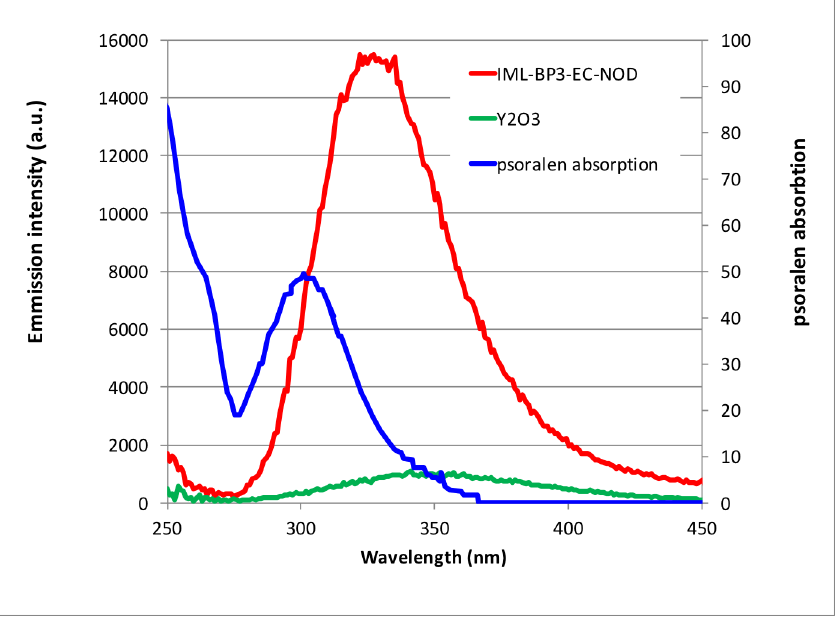
Fig 1. Light output from X-PACT phosphors under x-ray stimulation. The new phosphors (red line) are much brighter than previous versions evaluated in [25] (green line). The absorption spectrum of psoralen is shown for comparison (blue